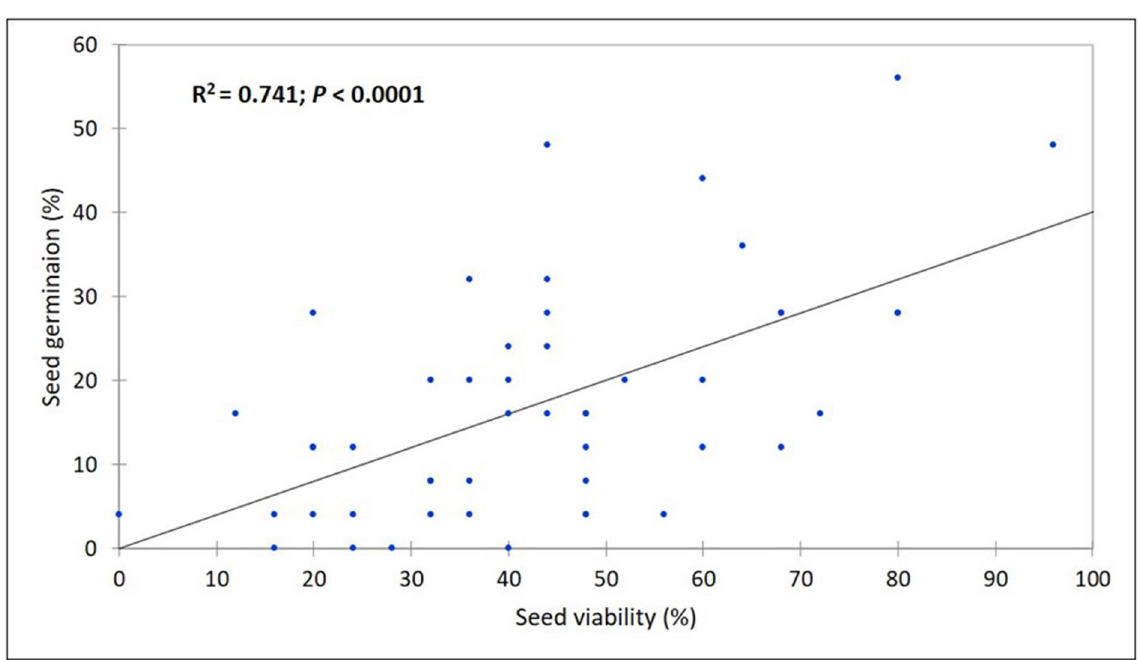
Figure 5. Simple linear regression analysis of seed germination and seeds viability traits showing a significant and positives relationship between these two